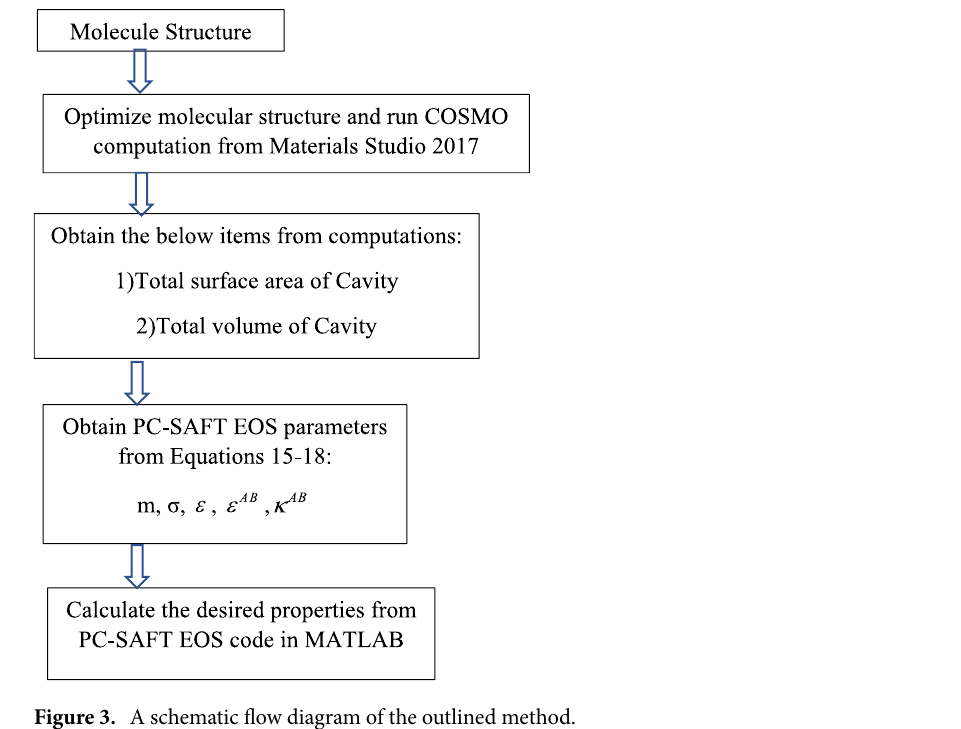
Figure 3. A schematic flow diagram of the outlined